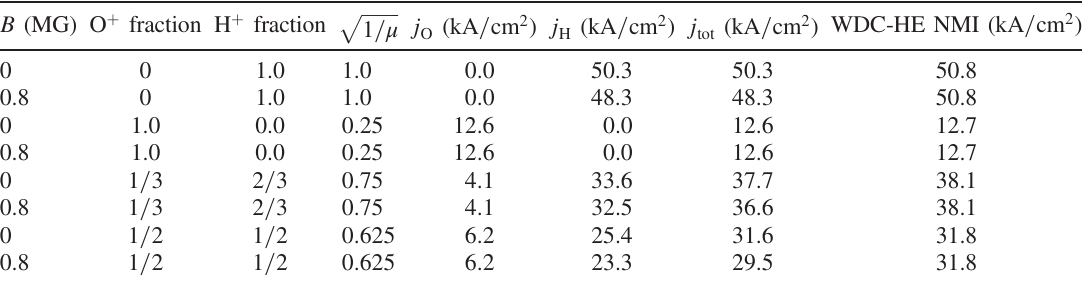
TABLE II. Summary of the single and double ion species, 1D ES simulation results and comparisons with